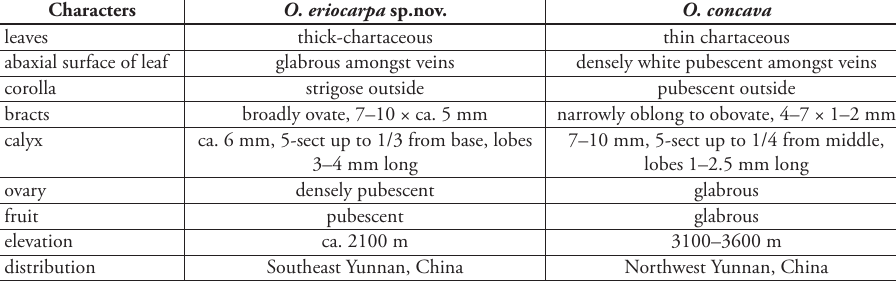
Table 1. Differences in characters between Oreocharis eriocarpa and O. concava in Gesneriaceae.